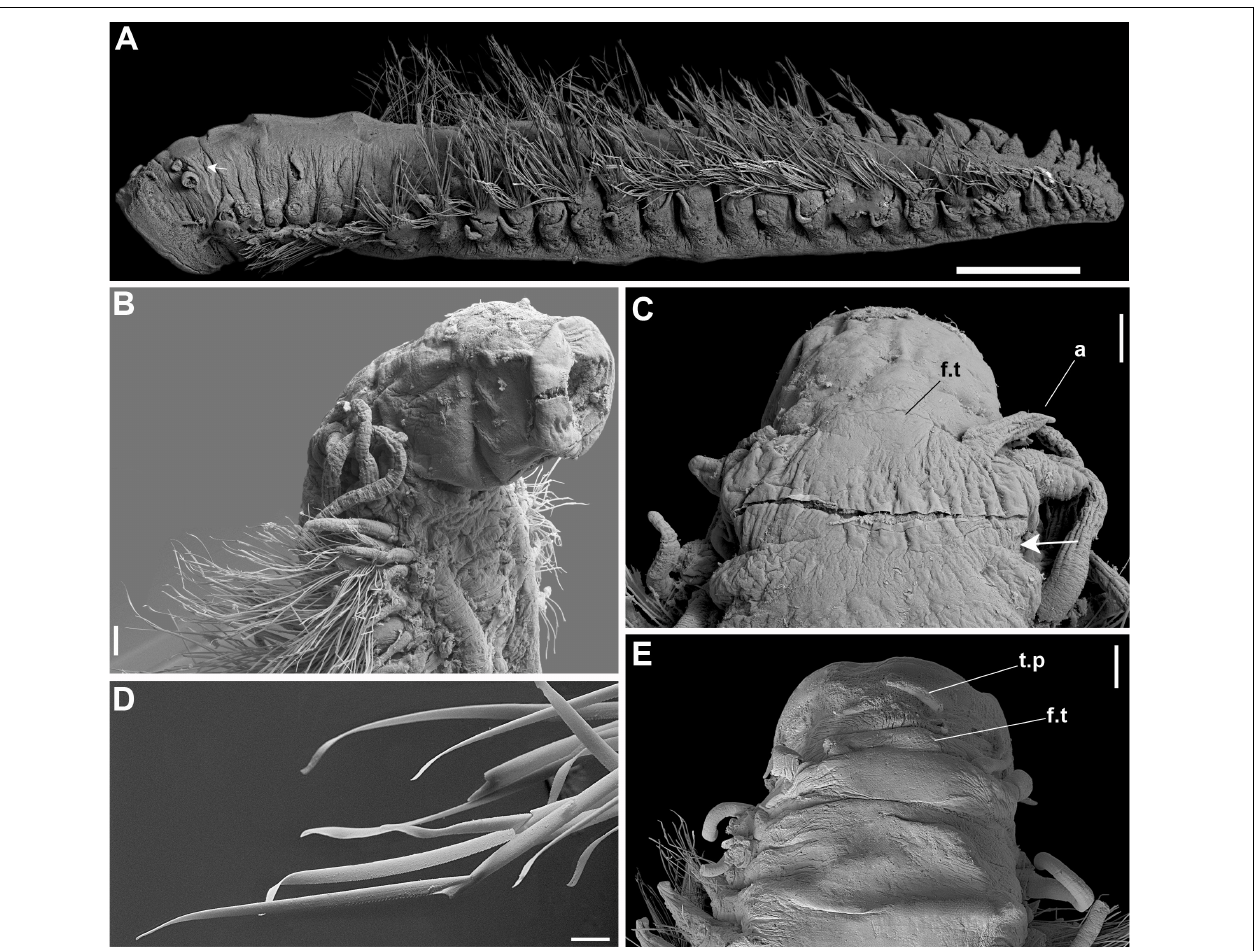
FIGURE 7 | (A–E) Sirsoe maximiano sp. nov. (A) complete specimen, lateral view; (B) anterior end, lateral view; (C) anterior end, dorsal view; (D) neurochaetae; (E) anterior end, dorsal view. a, lateral antenna; f.t, frontal tubercle; t.p, terminal papilla; white arrows on (A,C) indicate nuchal organs. Scales: (A) 1 mm; (B,C) 100 µ m; (D) 20 µ m; (E) 200 µ m.